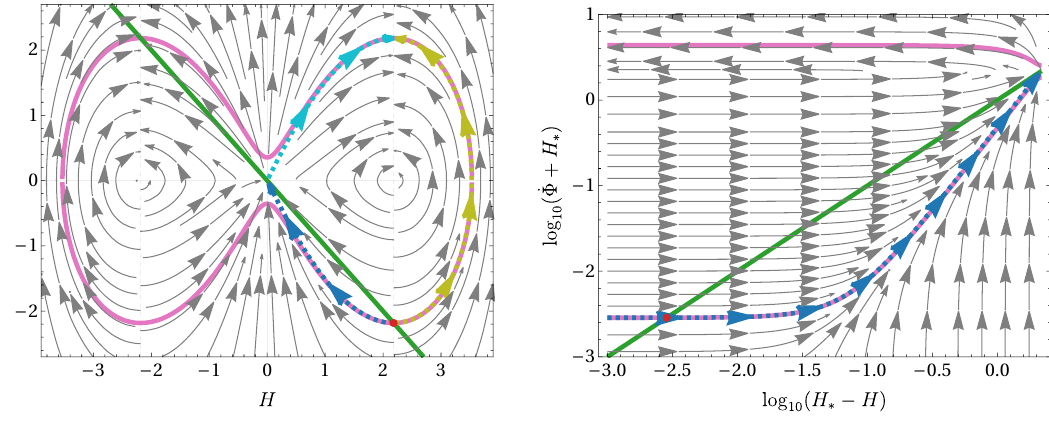
Figure 4 . Same plots as figure 3, except now for matter with w = 0 and λ = 2 . The following numerical value is used for the pink ‘initial’ constraint curve: e Φ 0 ¯ ρ 0 = 10 − 2